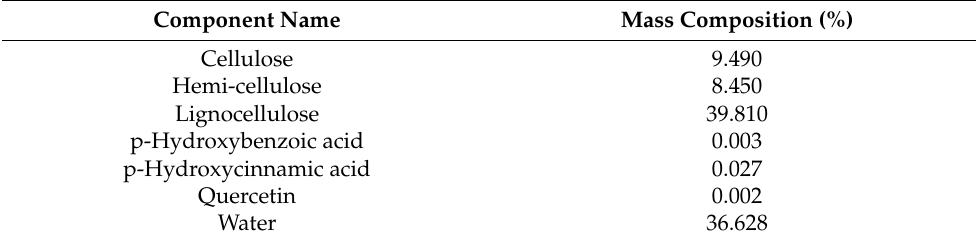
Table 1. The biomass composition of longevity spinach